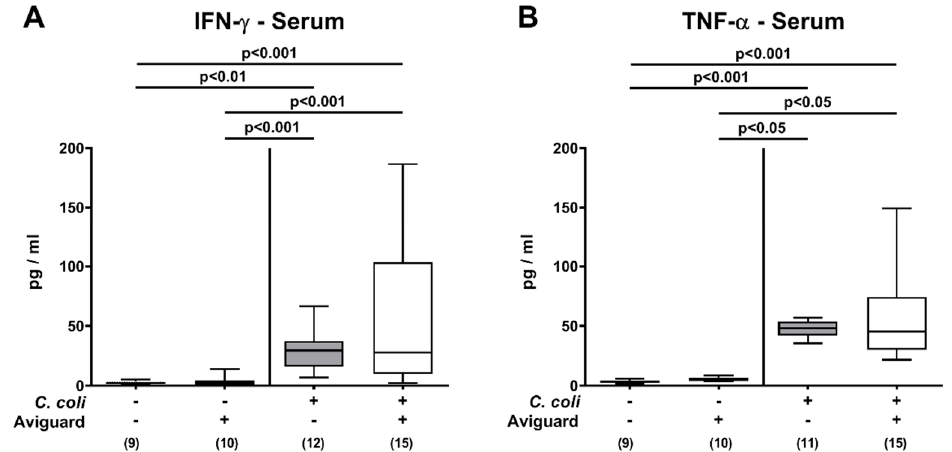
Figure 7. Systemic proinflammatory cytokine secretion following peroral Aviguard ® treatment of C. coli -infected secondary abiotic IL-10 − / − mice. Mice were infected with a C. coli patient isolate on day (d) 0 and d1 by gavage. On d2, d3 and d4 post-infection (p.i.), mice were perorally challenged with the probiotic formulation Aviguard ® (white boxes) or received placebo (gray boxes). On day 6 p.i., ( A ) IFN- γ and ( B ) TNF- α concentrations were measured in serum samples. The box plots indicate the 25th and 75th percentiles of the medians (bar within boxes). Total range, significance levels (p values) calculated by the Kruskal–Wallis test and Dunn’s post-correction and numbers of analyzed mice (in parentheses) are indicated. Outliers were excluded after identification by the Grubb’s test ( α = 0.001). Pooled data were derived from four independent experiments. +, with; − , without.